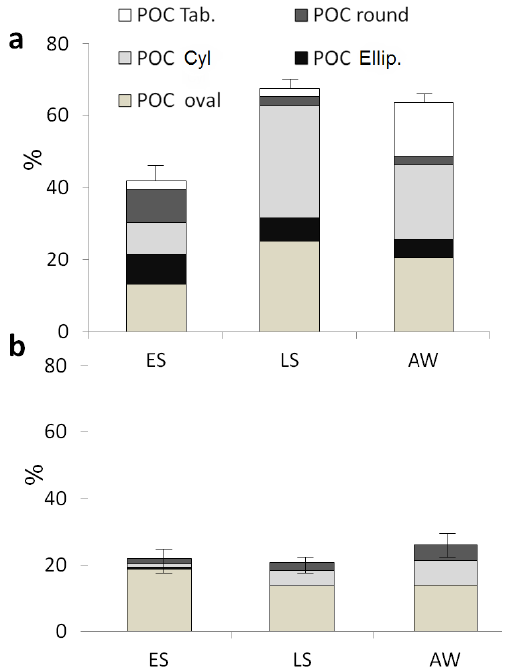
Figure 7. %FPC to total POC of each FP types during early season (ES), late season (LS) and autumn–winter (AW) at P3 (upper) and P2 (lower). Values were averaged over the period 2008–2011. Note: cylindrical attributable to krill and large copepods, tabular to salps, ovoidal to small copepods and pteropods, round to small copepods and amphipods, and ellipsoidal to larvaceans. Error bars indicate the standard error of the mean.